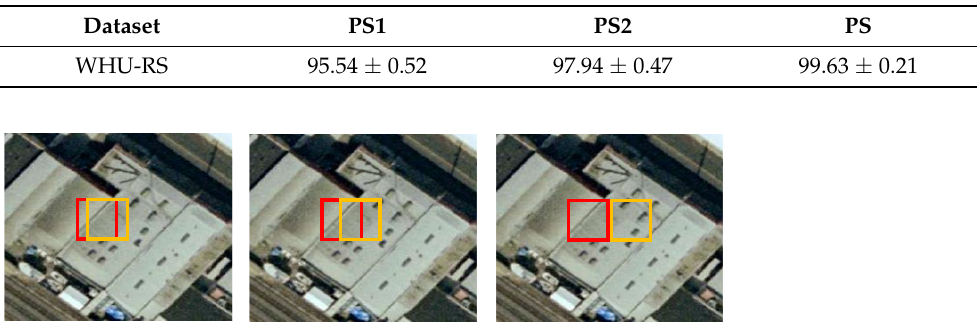
Figure 9. Images indicate window size and stride for each one of the three. ( Left – right ): sample windows shows high redundancy. Center: sample windows with a pixel width 2 display overlapping. Right: the proposed sample windows show negligible